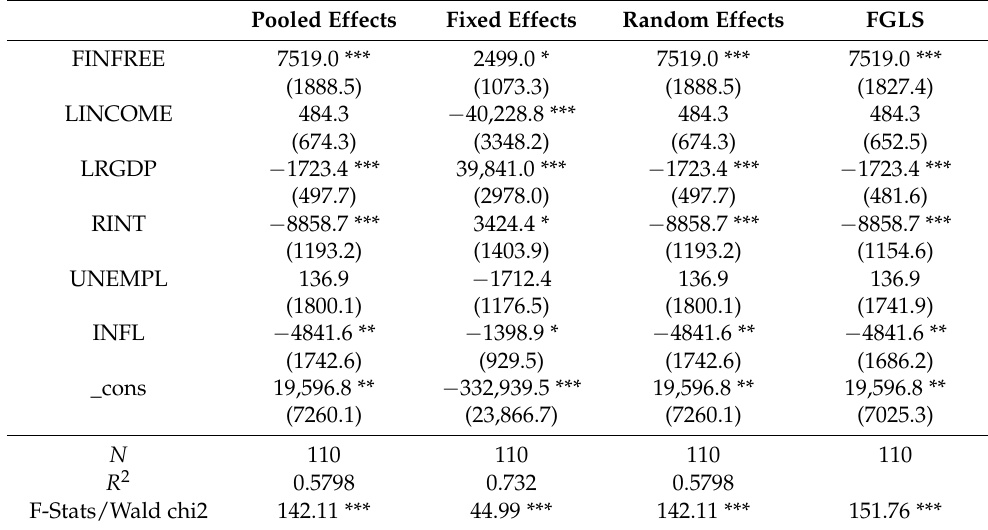
Table 4. Panel regression results with life insurance density as the dependent